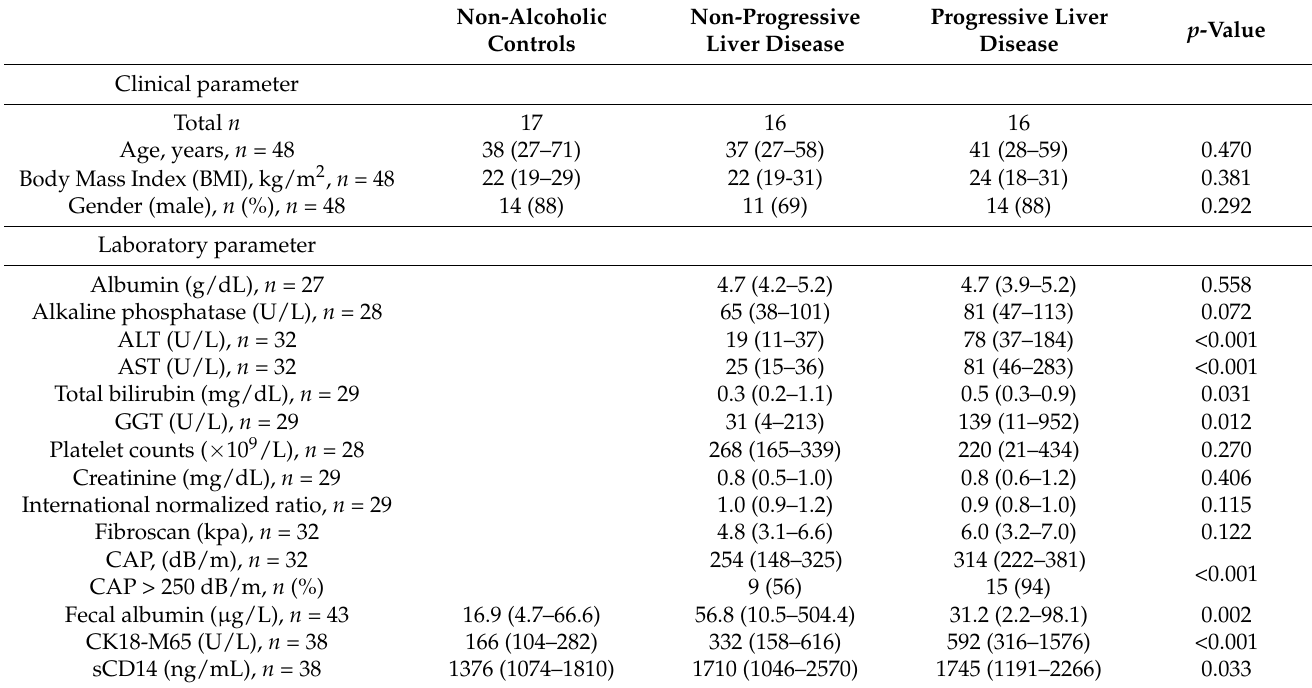
Table 1. Subject